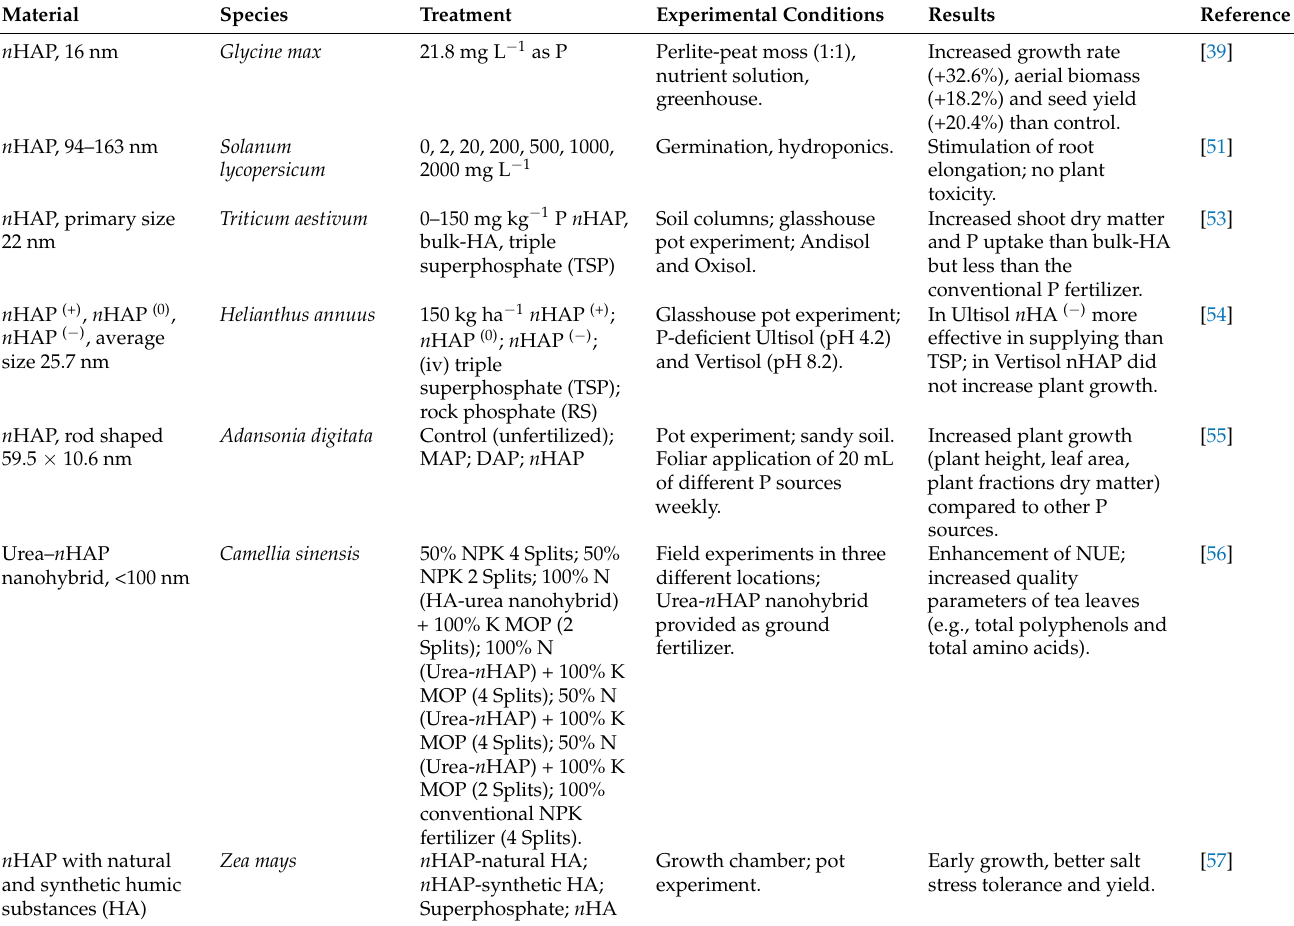
Table 1. Nano-hydroxyapatite as source of